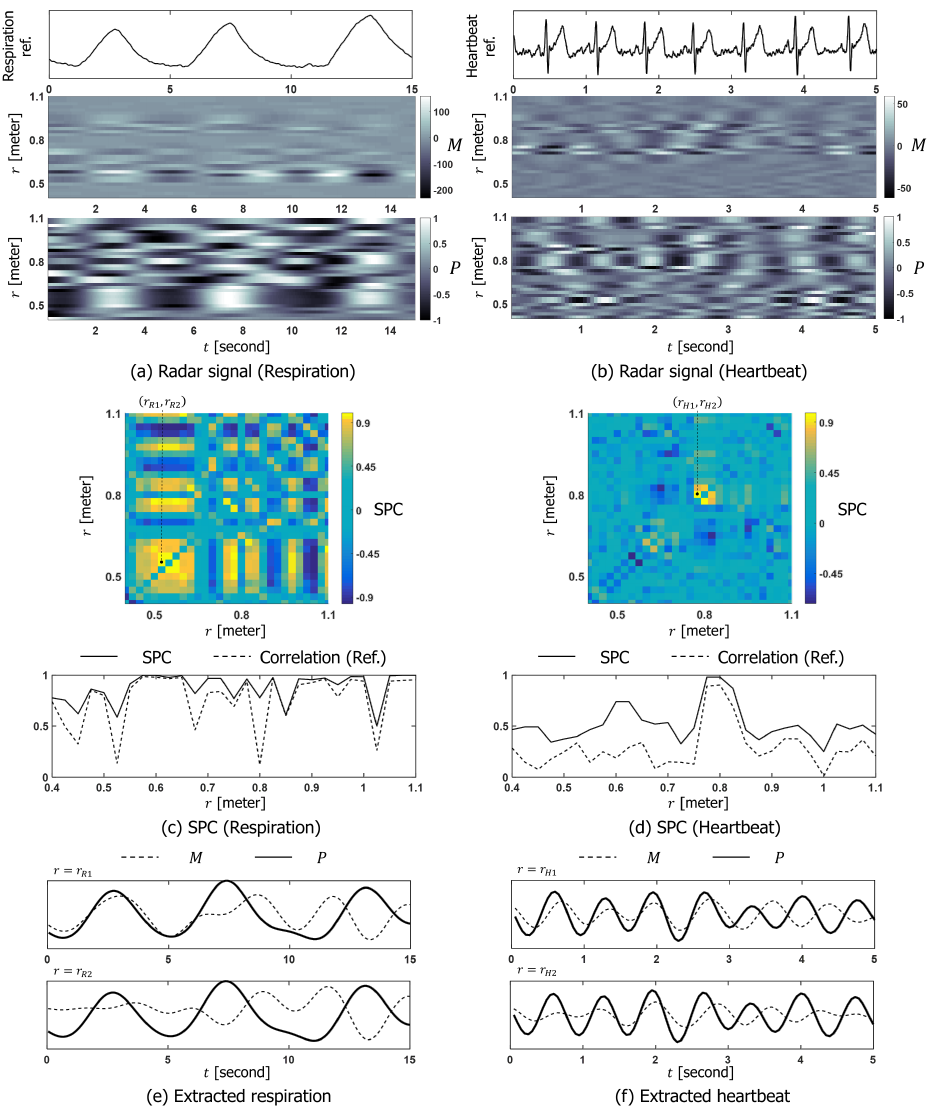
Figure 4. SPC and extracted vital-sign signals. ( a , b ) M ( t , r ) and P ( t , r ) for respiration and heartbeat, ( c , d ) SPCs, for respira- tion and heartbeat, and ( e , f ) extracted respiration and